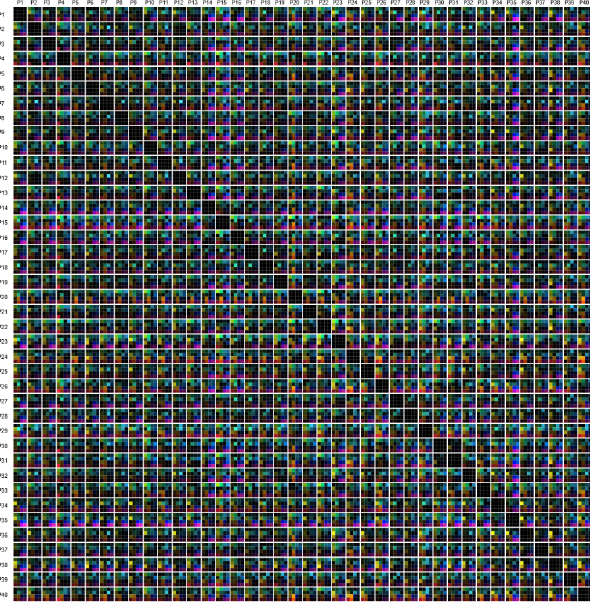
Figure 13. Similarity matrices including all participants. All 16 similarity metrics are depicted by color-encoded. The order of the participants is increasing from left to right and top to bottom, according to the participant ID.